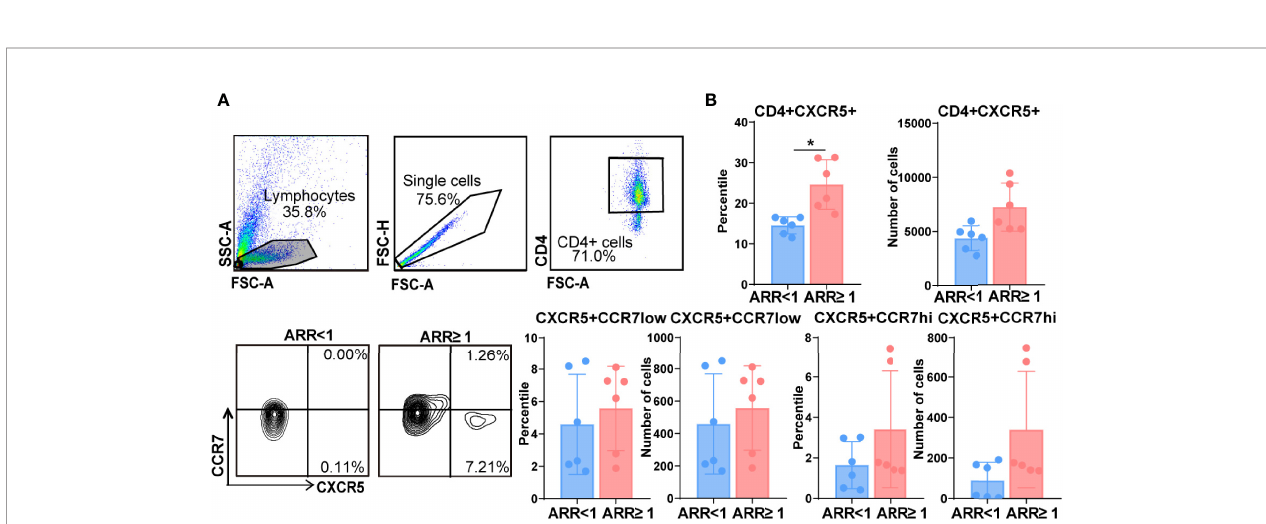
FIGURE 2 | Increased frequency of follicular helper T (Tfh) cells in patients with neuromyelitis optica spectrum disorder (NMOSD) with a high annual recurrence rate. (A) Comparison of the frequencies of circulating Tfh cells in patients with two groups patients with NMOSD. Representative expressions of CXCR5+CD4+ T cells, CXCR5+CCR7 low Tfh progenitors, and CXCR5+CCR7 hi Tfh were detected by fl ow cytometry. (B) Flow cytometric analysis of the different phenotypes of Tfh. N = 6, *p < 0.05. ARR, annual recurrence rate.